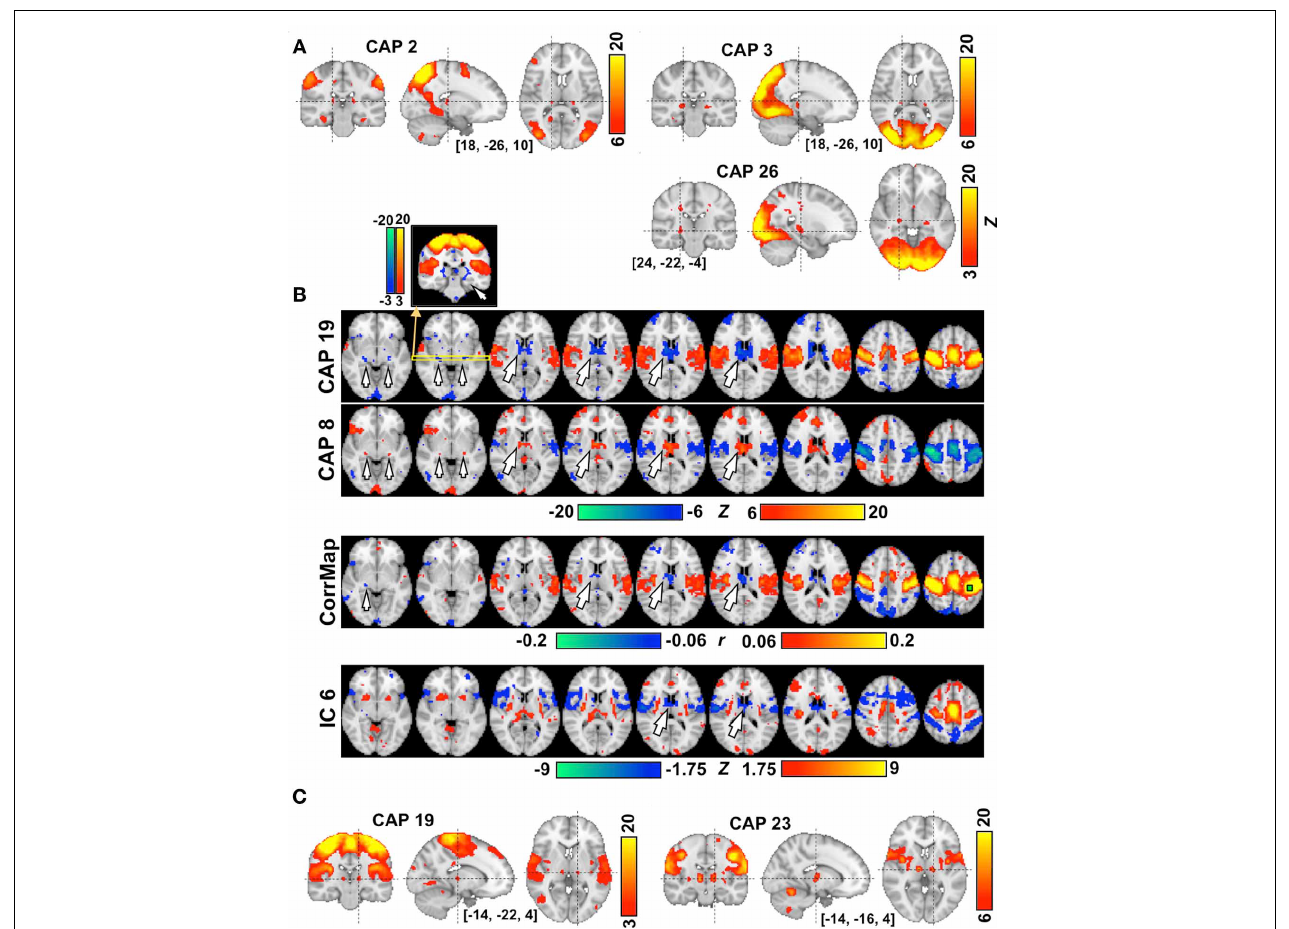
FIGURE 4 | The involvement of thalamic nuclei in CAPs. (A) CAPs in visual areas show co-activations in the LGN (CAP 26) and in different subdivisions of the Pulvinar (CAPs 2-3) each with different involvement of visual cortex. (B) CAPs in sensori-motor areas showing anti-phase activity at the AN/MDN of the thalamus (big arrows) and some areas surrounding the posterior thalamus (small arrows). The correlation map (CorrMap) seeded in